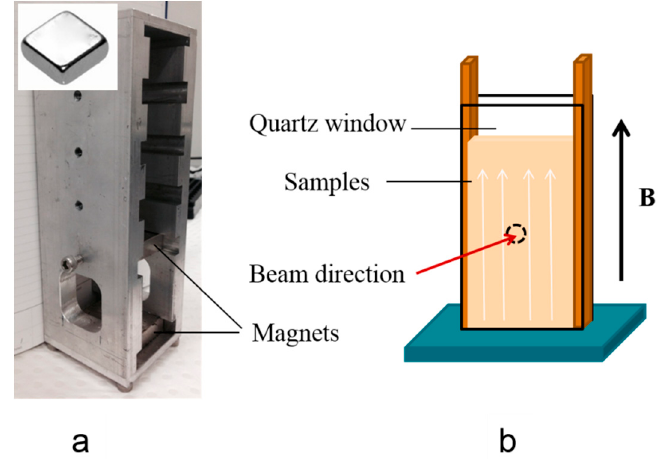
Figure 1. ( a ) The aluminium frame, used to position the two magnets; and ( b ) the cell used for in situ SAXS measurement.